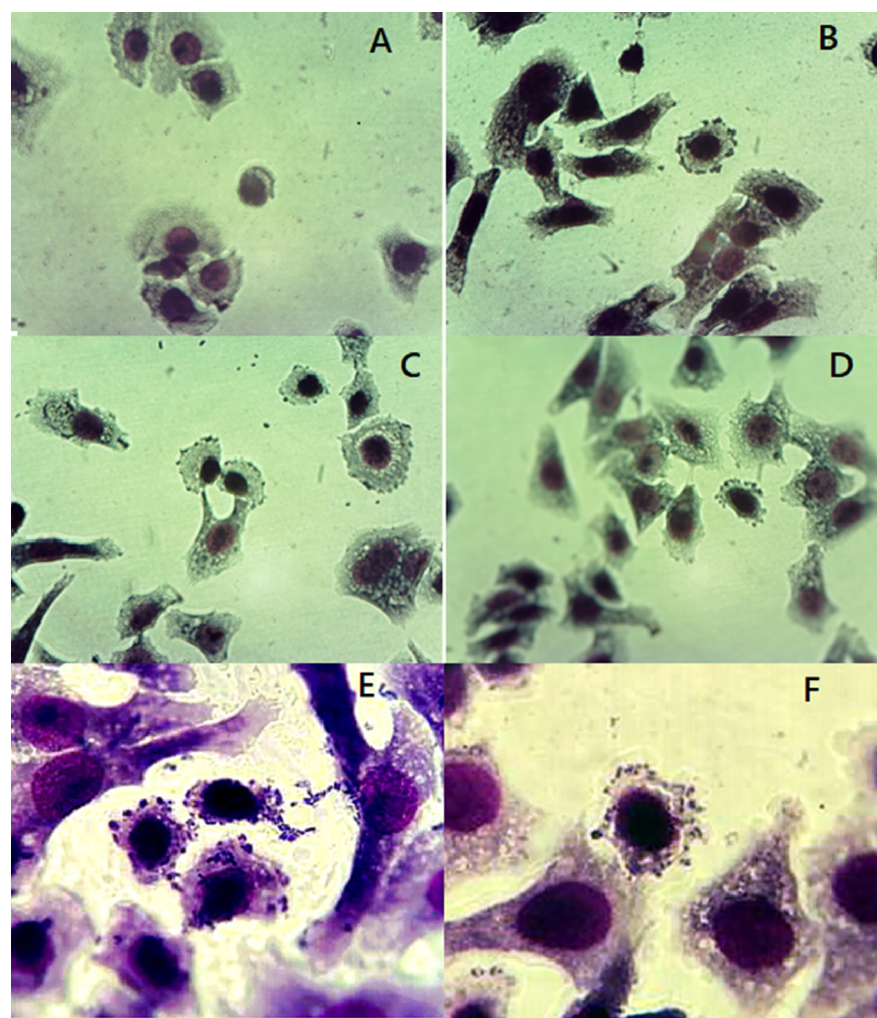
Figure 1. E. coli adhesion assays in Hep-2 cells. ( A ) Uninfected Hep-2 cells, ( B ) Hep-2 cells infected with control strain EPEC O127:H6, ( C – F ) E. coli strains esc V + , eae + isolated from carnivores. Localized adhesions are observed, also lesions suggestive of pedestals.